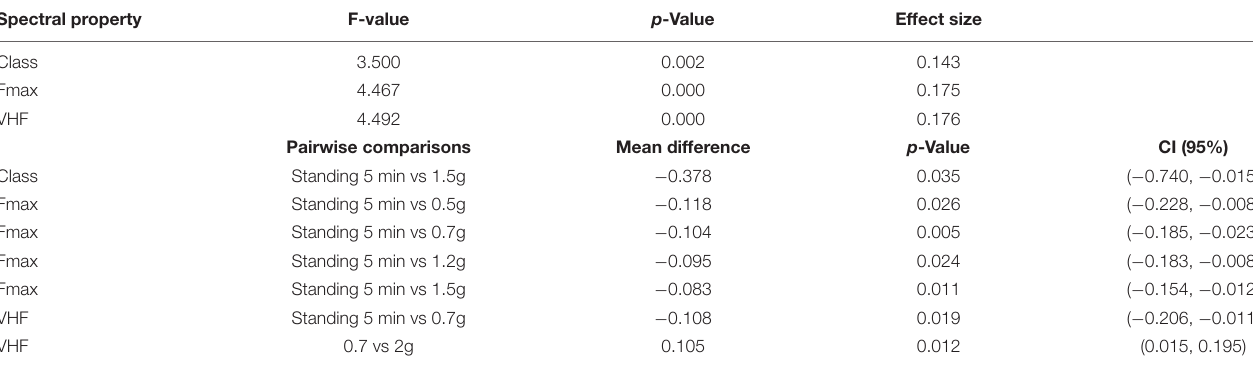
FIGURE 2 | HR for each of the 24 participants in the standing position (red dotted line) and at each artificial gravity (AG) load (denoted with a diamond of a different color: blue, 0.5g; green, 0.7g; red, 1.0g; magenta, 1.2g; cyan, 1.5g; yellow, 1.7g; black, 2.0g). TABLE 5 | Visualization of the spectral heart rate variability (HRV) features that yielded statistically significant results due to the artificial gravity (AG) training. Spectral property F-value p